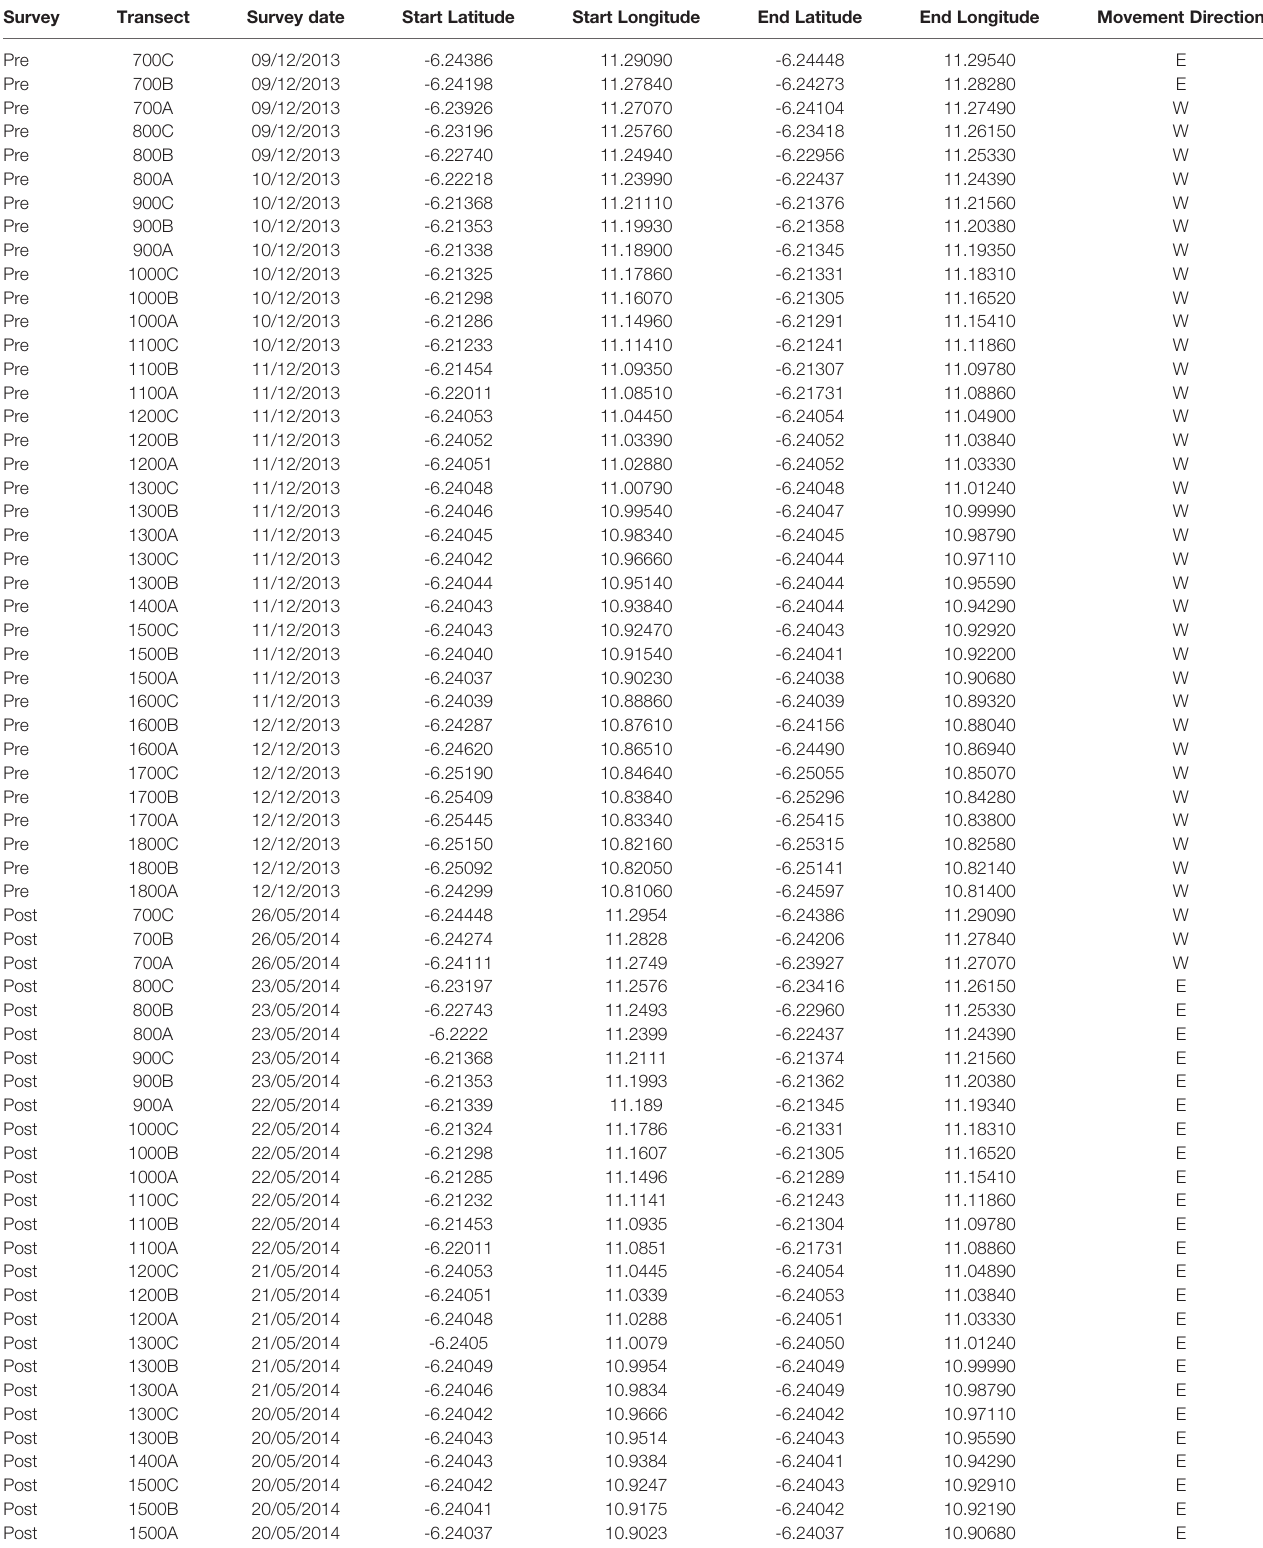
TABLE 1 | Positions of remotely operated vehicle transects and approximate movement direction.